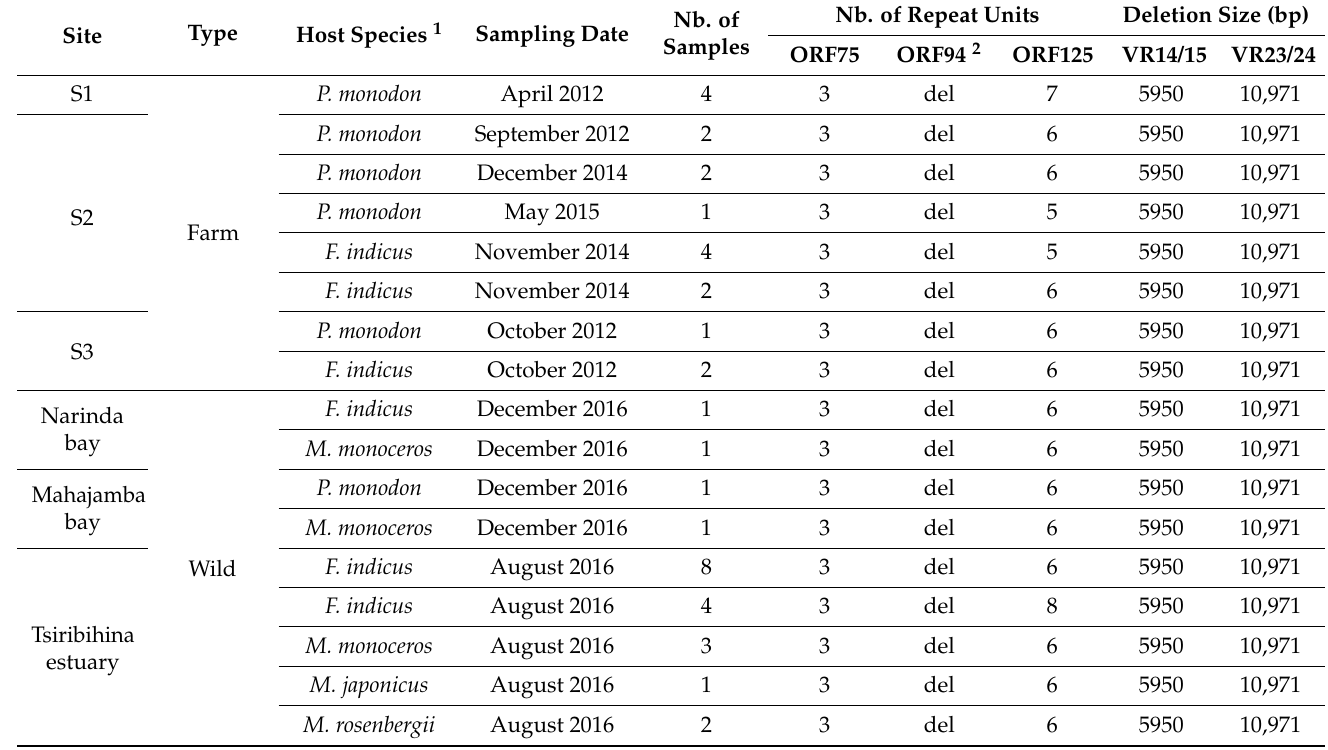
Table 2. Study samples, number of repeat units (No of RUs) in VNTRs regions (ORF75, ORF94, ORF125) and deletion size in variable regions (VR14/15, VR23/24) of